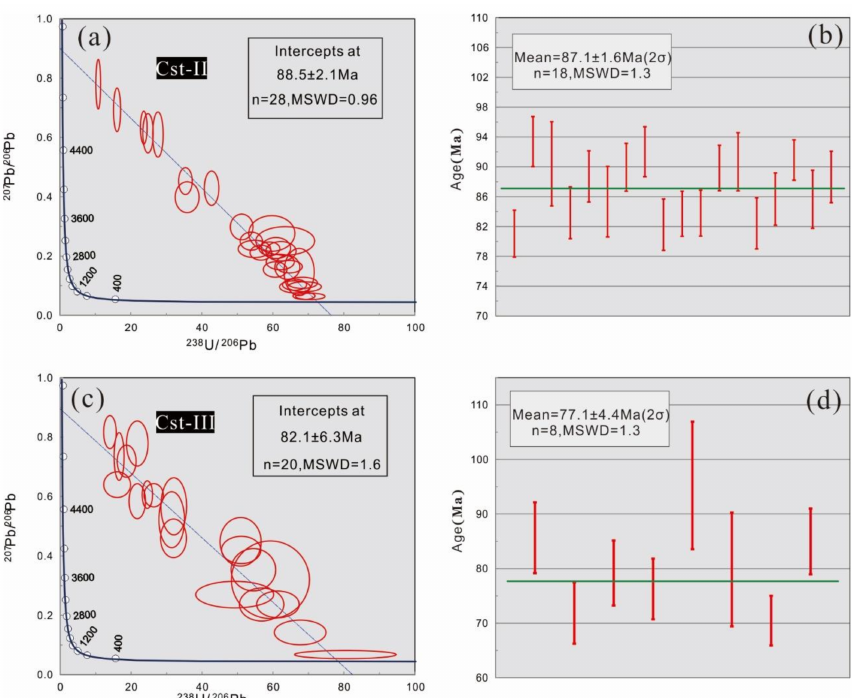
Figure 5. Tera-Wasserburg U–Pb concordia plots and weighted mean diagram of 206 Pb/ 238 U age by 207 Pb-based correction for cassiterite from the Dulong Sn-Zn-In deposit. ( a , b ) Cassiterite-sulfide ore (Cst II), sample DL18-153. ( c , d ) Cassiterite-quartz vein ore (Cst III), sample